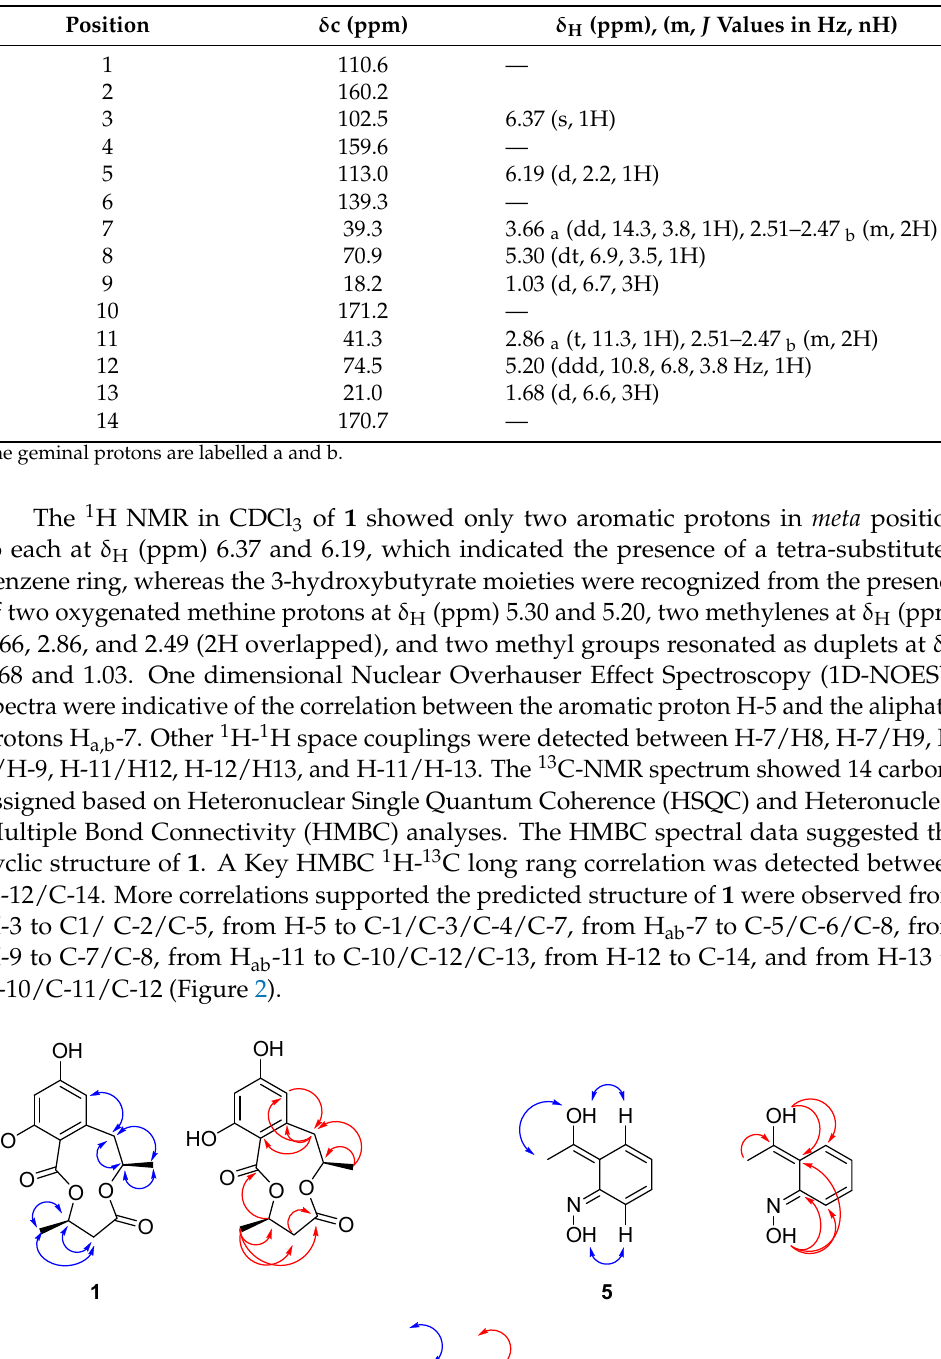
Table 1. 1 H-NMR (CDCl 3 , 600 MHz) and 13 C-NMR (CDCl 3 , 150 MHz) of talarodioxadione 1.